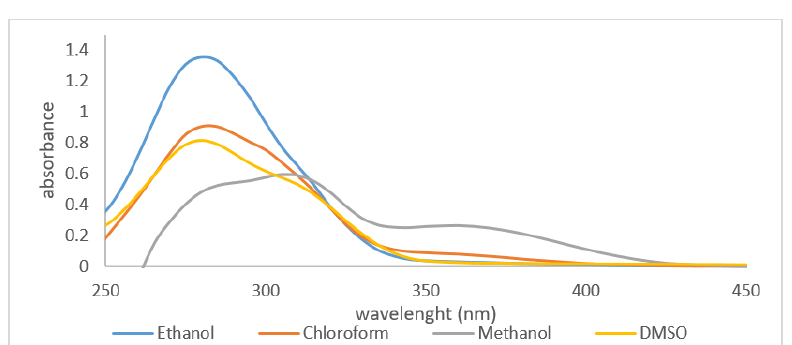
Fig. 2. Electron absorption spectra of Schiff base (A 2 ) in different organic solvents